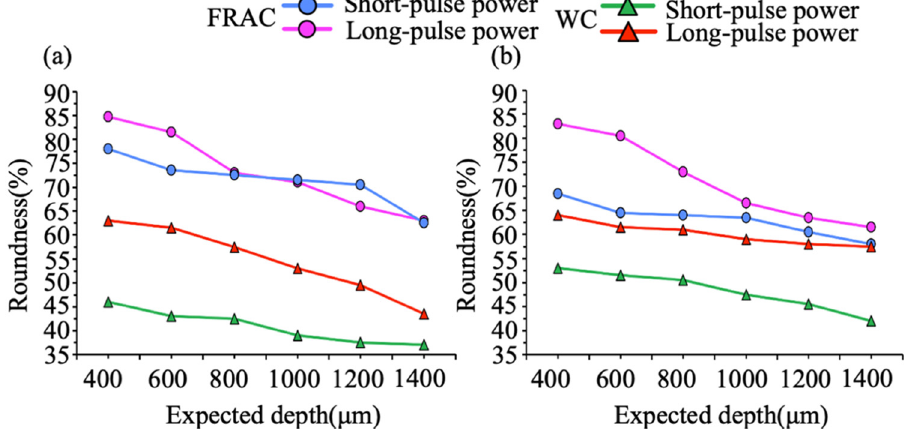
Figure 13: The roundness factor under di ff erent pulse of blind holes: ( a ) tungsten steel electrode; ( b ) brass electrode ( Short - pulse power: frequency = 120 kHz, pulse width = 3 µs, current = 2.5, voltage = 90 V, gain coe ffi cient = 15; Long - pulse power: frequency = 130 kHz, pulse width = 5 µs, current = 4.5, voltage = 90 V, gain coe ffi cient = 30 )